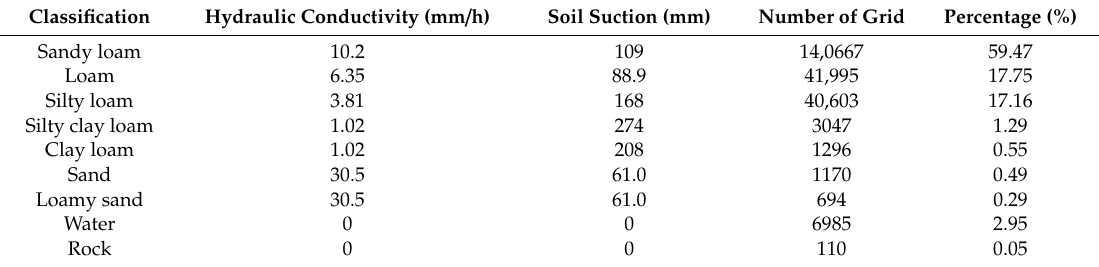
Table 3. Portion percentage of soil classification and the corresponding parameters for Green-Ampt.